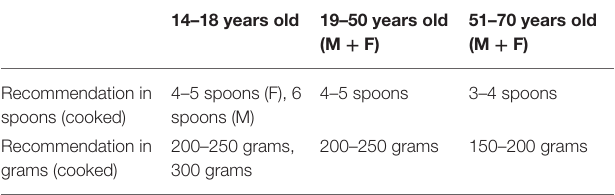
TABLE 2 | Water uptake factors between dry and cooked pasta. Portion dry Portion (in cups) cooked (in